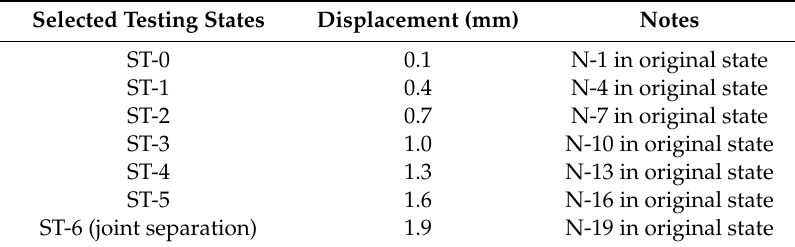
Table 4. Selected and renamed typical states.